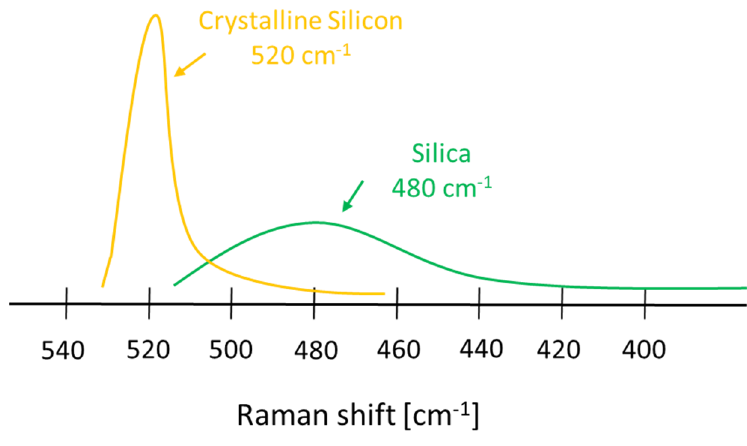
Figure 3. Comparison of Raman bandwidth and the efficiency of silicon and silica.